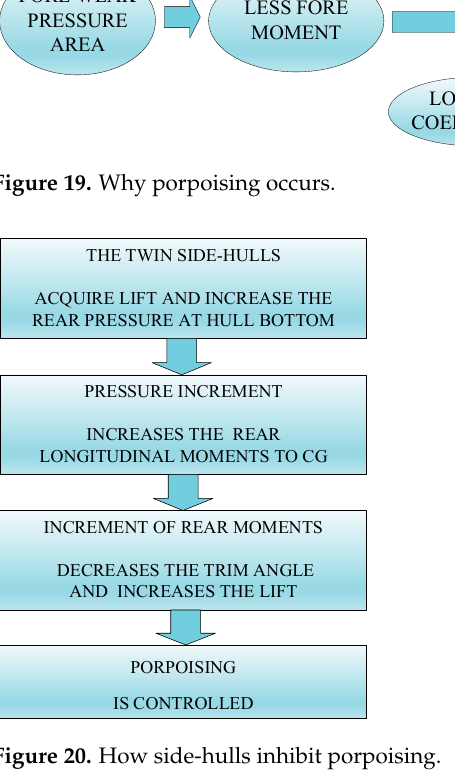
Figure 19. Why porpoising occurs.